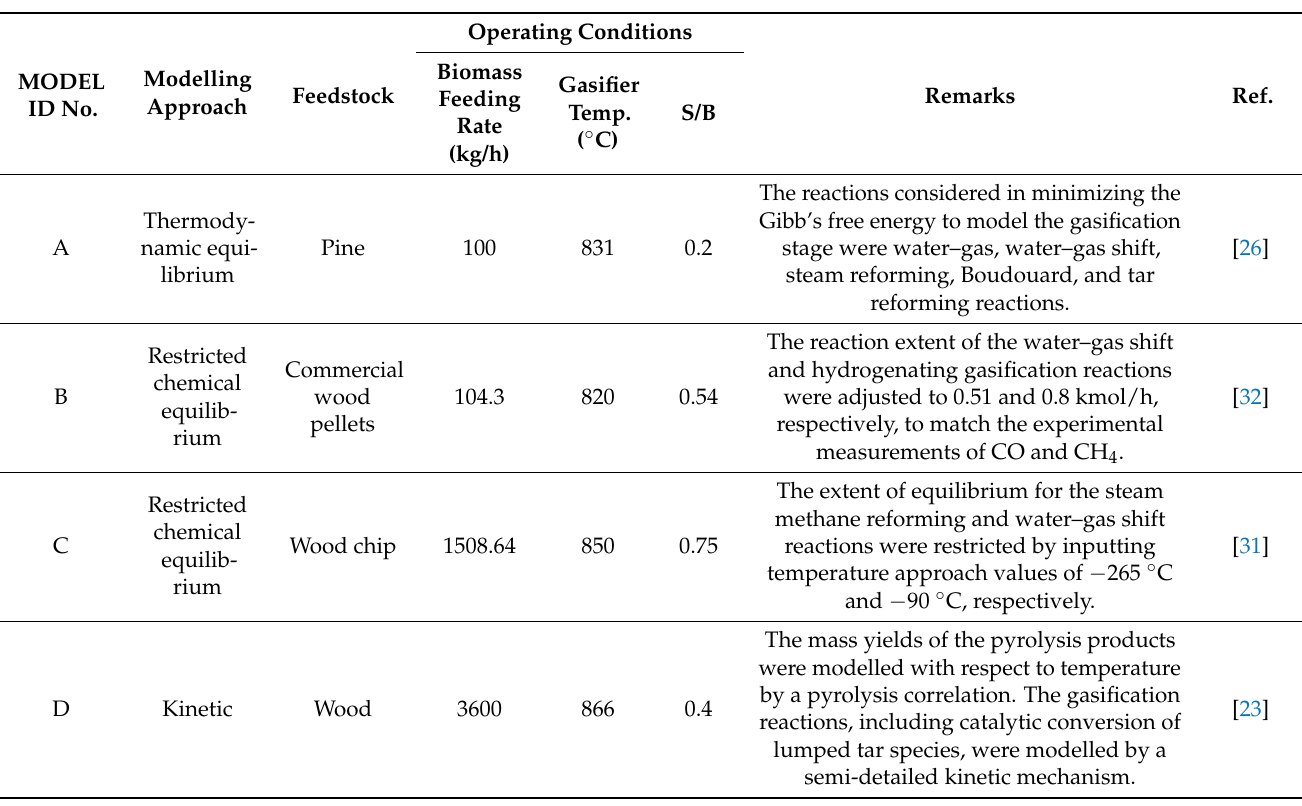
Table 6. Summary of related literature on the Aspen Plus modelling of woody biomass steam gasification in DFB